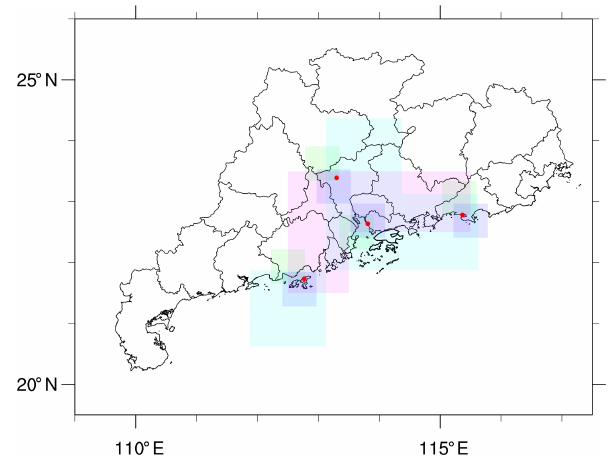
Figure 11. Locations of the selected surface observation stations (red dots) in Guangdong, China, with corresponding grid boxes from four EPS outputs: CMA (green), ECMWF (blue), JMA (cyan), and NCEP (magenta). Information of prefectural boundaries is ob- tained from GADM version 3.6 level 2 (available at